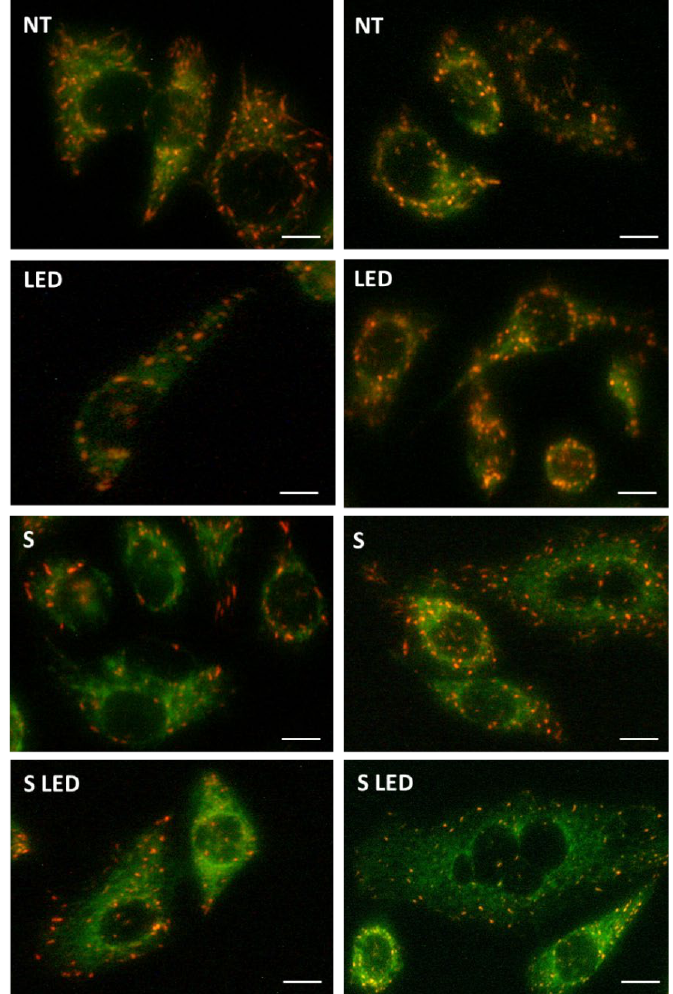
Figure 14. Confocal microscopy examination of JC-1 fluorescence in T98G cells. Cells (10,000/30 mm glass-dishes well) were incubated with 10 8 unloaded NPs (B) or NP BBR S (S) for an additional 24 h and subjected or not to light stimulation (447 nm and 1.2 mW/cm 2 of intensity); before fluorescence microscope examinations, JC-1 (1 µ M) was added for 15 min at 37 ◦ C and visualized using a Leica TCS SP8 confocal microscope at 63× magnifications (JC - 1 exc. = 497/594 nm; emiss. = 527/597 nm). Scale bars = 5 µm. To quantify polarized/depolarized organelles, a cytofluorimetric assay was per- formed, assessing mitochondrial depolarization as a decrease in the red/green fluores- cence intensity ratio. Cells (5 × 10 5 ) were placed onto 6-well plates and after 24 h of grow- ing (reaching about a 70– 80% confluence) were incubated for an additional 24 h with 10 8 untreated (NT) or NP BBR S and subjected, or not, to light stimulation (4 min at 447 nm and 1.2 mW/cm 2 of intensity). After trypsinization, BBR intracellular fluorescence was measur ed. Amnis Imagestream technology (using 488 and 642 nm laser excitations) was used to quantify fluorescent green and red spectra, following NPs administration and LED stimulation in T98G cells. As reported in Figure 15, a significantly increased trend of depolarized mitochondria was scored following NP BBR S internalization and, mostly, after LED stimulation, compared to untreated (NT) and LED-only treated cells.